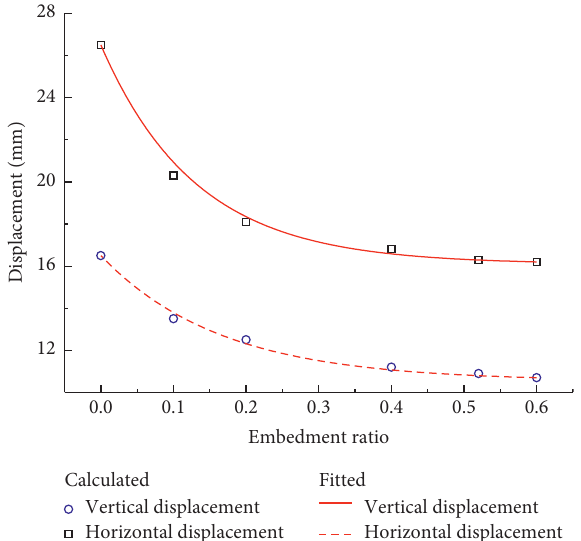
Figure 11: The influence of the pile embedment ratio on maximum